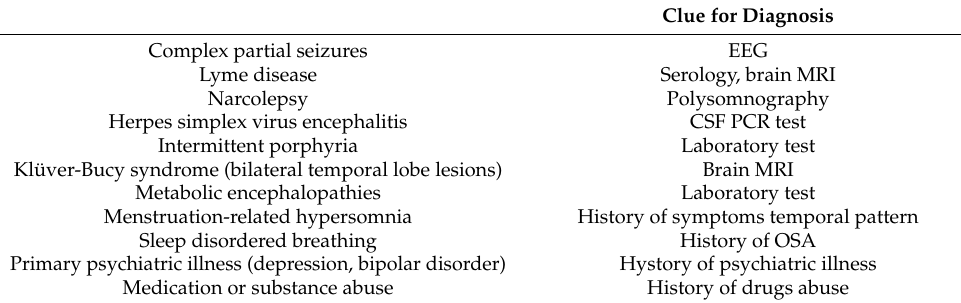
Table 4. Differential diagnosis of Kleine-Levin